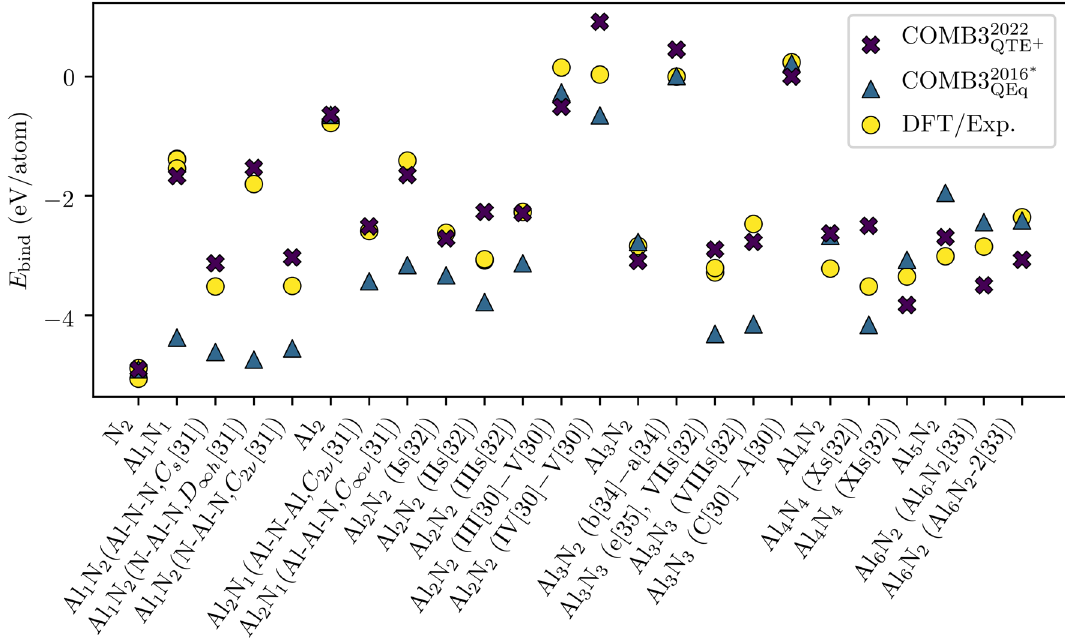
4 ) computed with COMB3 2022 6 , y and QTE + ≤ ≤